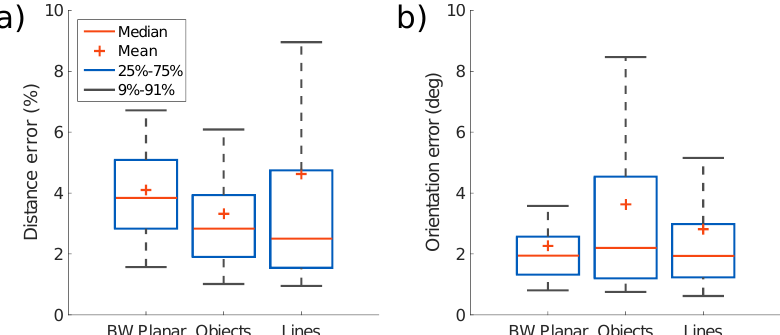
Figure 12. Absolute error statistics for the three test sequences presented. ( a ) Translational error as a percentage of scene depth. ( b ) Rotational error in terms of the geodesic distance between the estimated and the ground truth orientations.